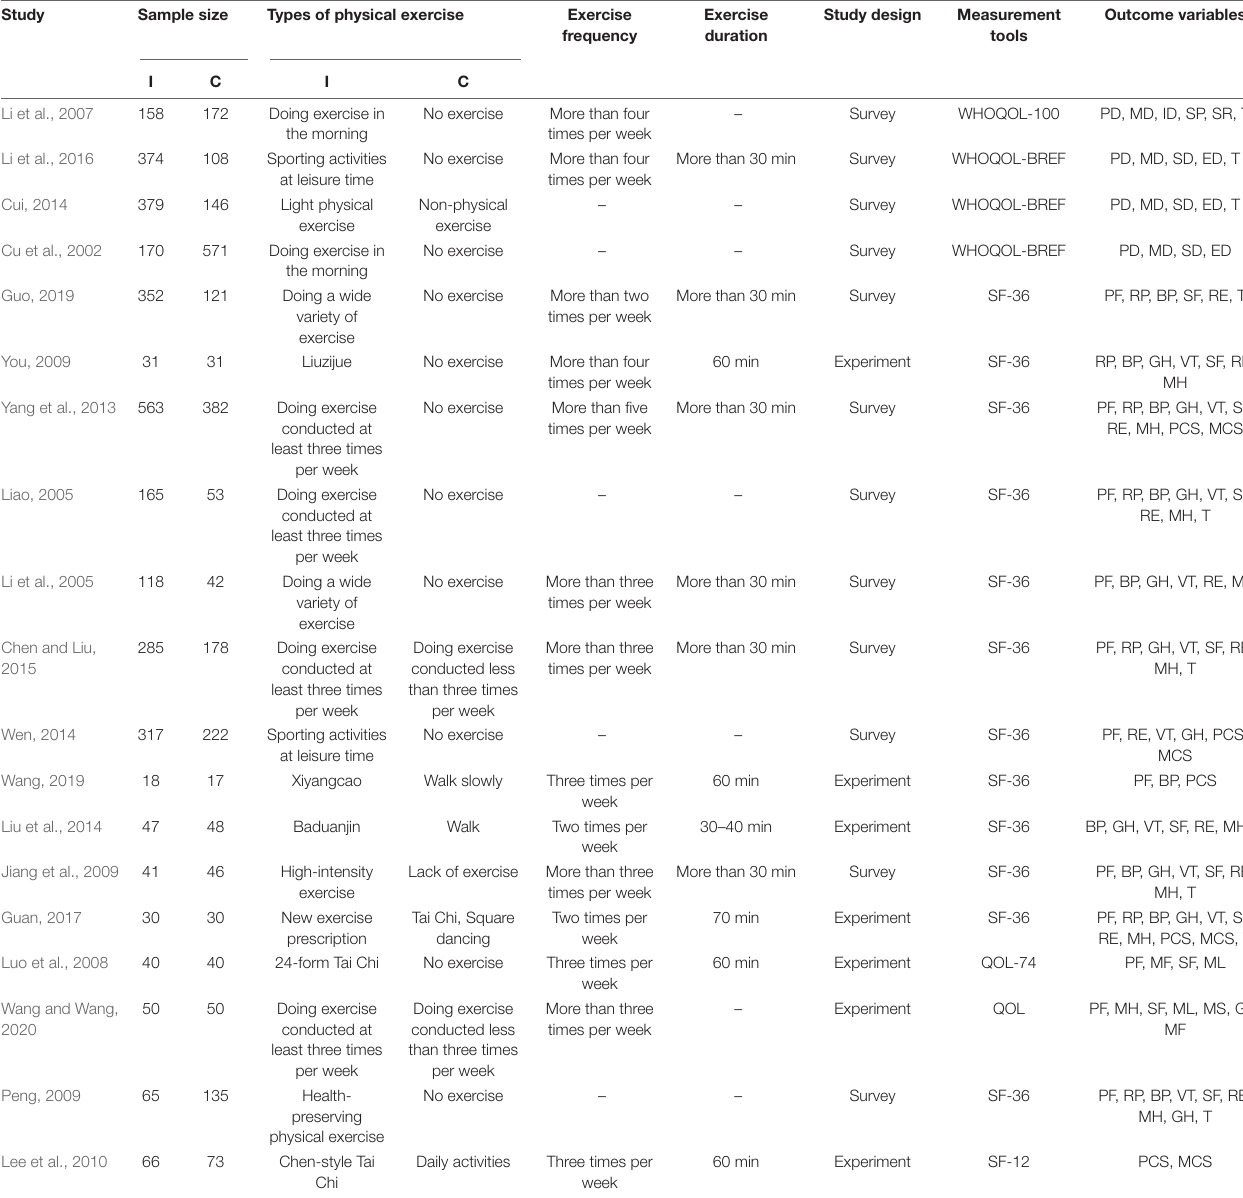
TABLE 2 | Characteristics of studies included in the systematic review. Study Sample